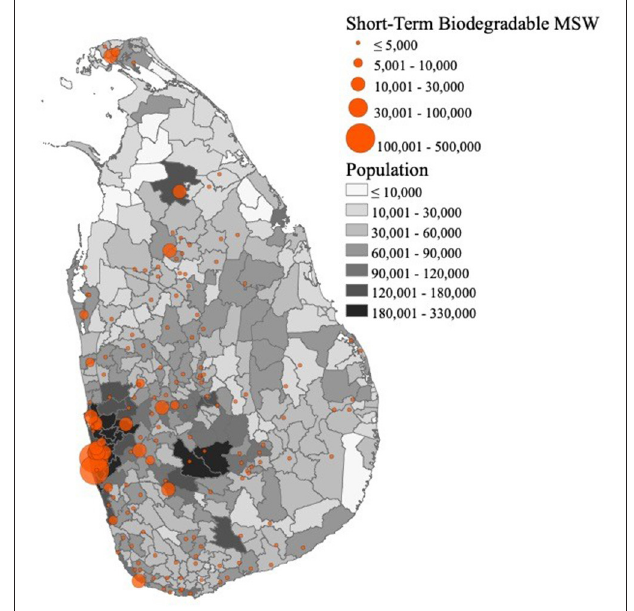
FIGURE 1 | Locations of composting facilities established in Sri Lanka’s Pilisaru Program , with short-term biodegradable MSW (kg/day) in 2012 shown for the corresponding local authorities. Population in 2012 is also shown by local authority. Data source: Central Environmental Authority